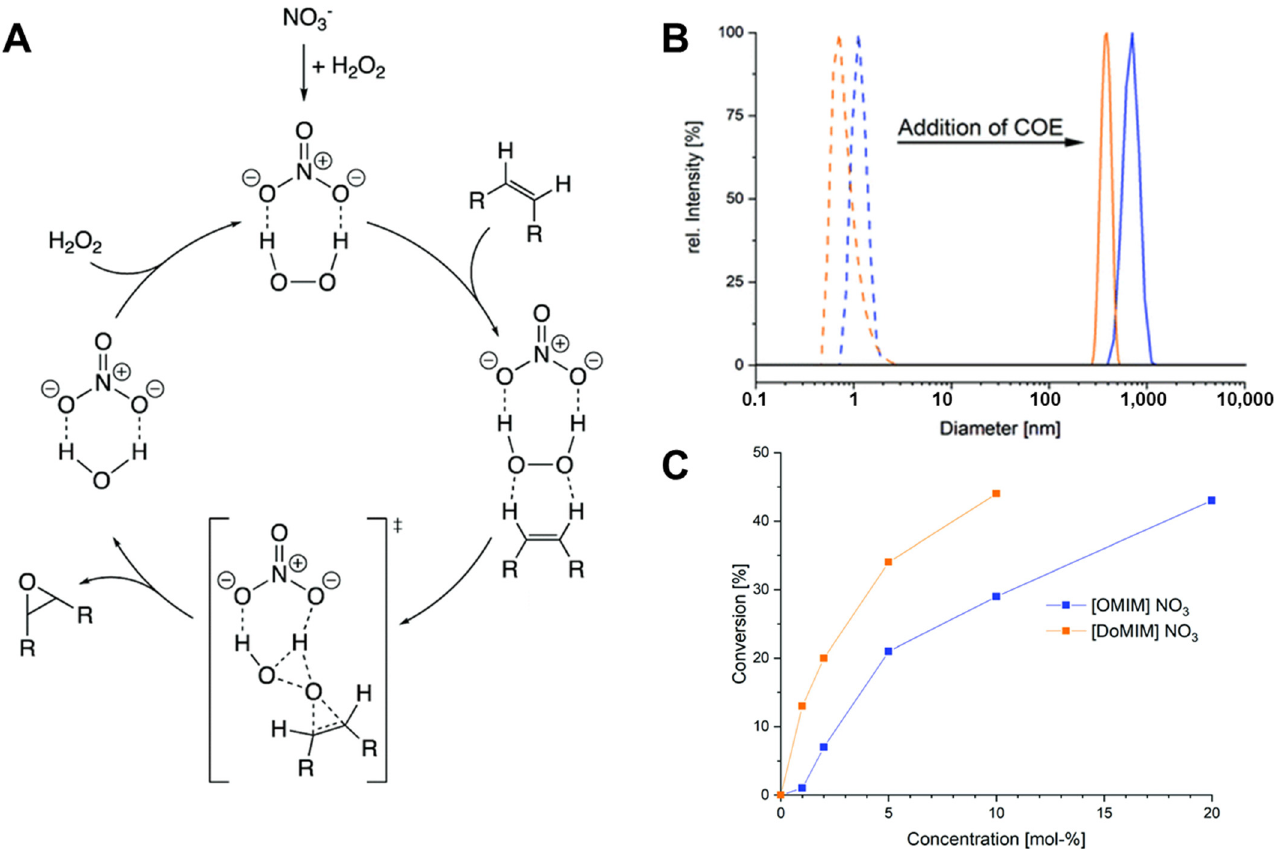
Figure 2. Surface-active imidazolium-based ionic liquids (IL) are known to form micelles in water and are capable of solubilizing cyclooctene to carry out metal-free epoxidation in water catalyzed by H 2 O 2 . ( A ) Proposed mechanism of the activation of H 2 O 2 and olefin epoxidation by the nitrate anion. ( B ) Micelle size in 50 wt% H 2 O 2 at 80 °C measured by dynamic light scattering. Blue: 357 mM [OMIM][NO 3 ]. Orange: 357 mM [DoMIM][NO 3 ]. Dashed line: IL solutions with ‘empty’ micelles; solid line: micellar solution after saturation with cyclooctene as model substrate. ( C ) Conversion of cyclooctene in the epoxidation with [OMIM][NO 3 ] (blue) and [DoMIM][NO 3 ] (orange). Product separation was achieved by decanting the supernatant phase. Adapted with permission from [53].